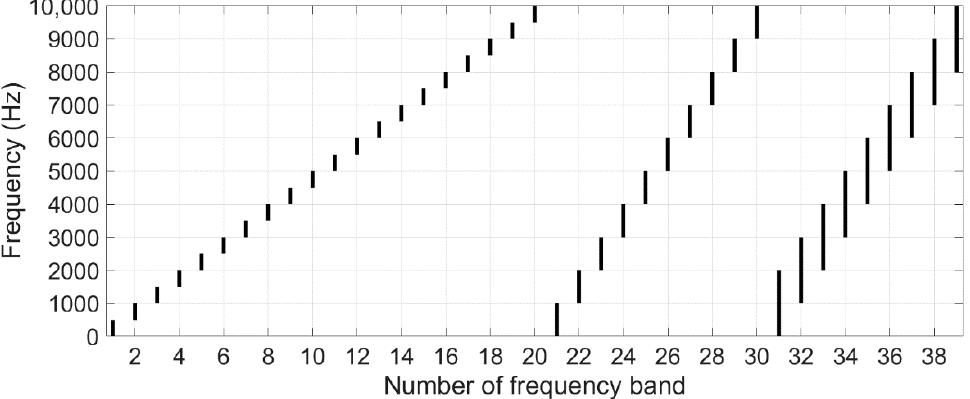
Figure 3. Illustration of 39 frequency bands used in signal filtering.